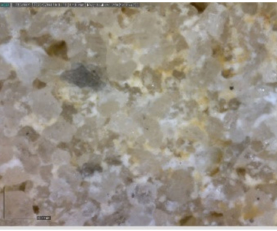
Figure 6. Hoˇrice sandstone DinoLite microscope image, magnification 200 × .